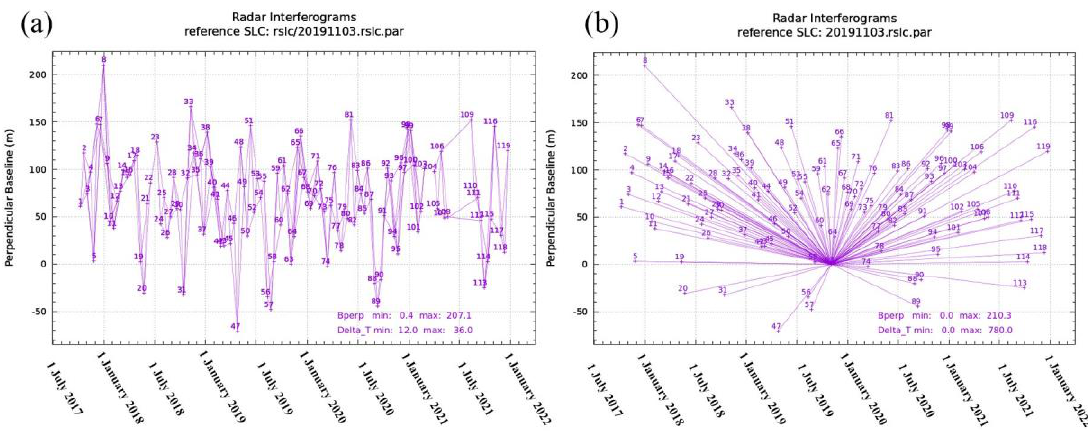
Figure 5. The spatiotemporal baselines of ( a ) SBASInSAR and ( b )